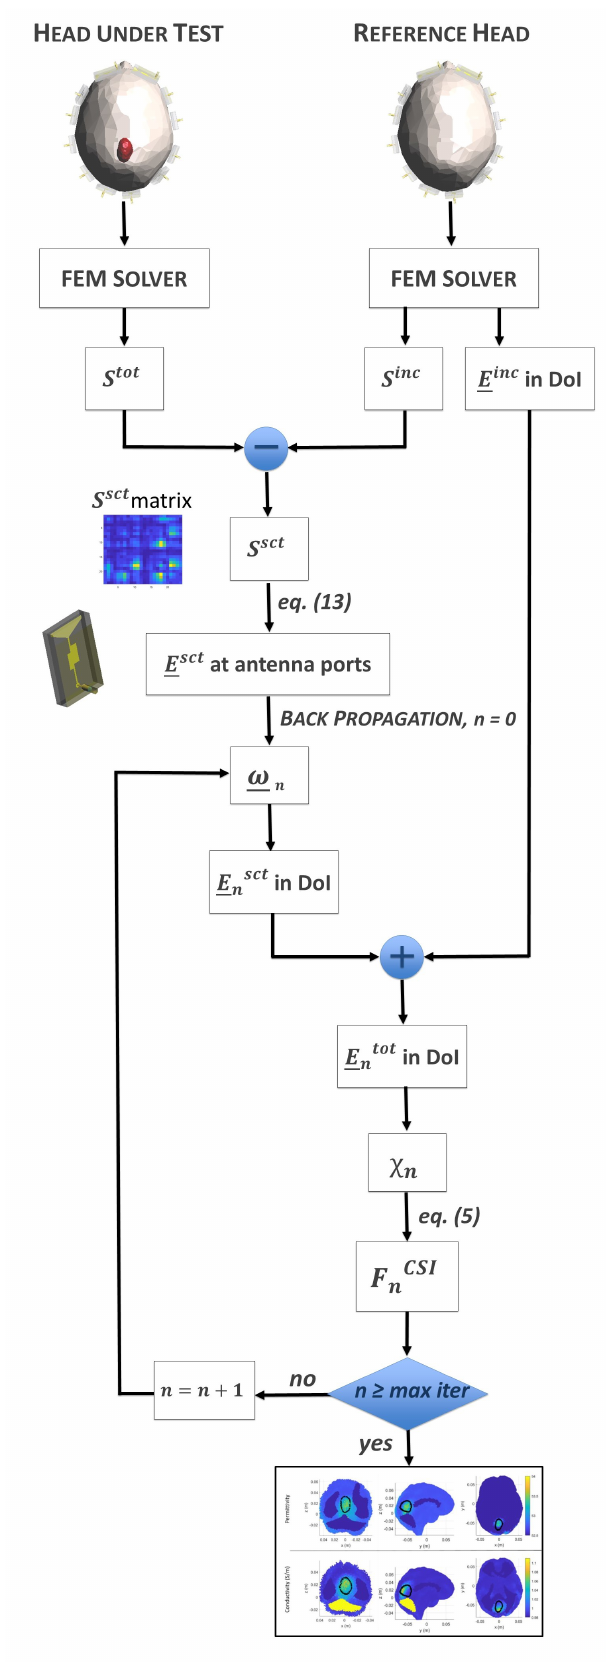
Figure 4. Flowchart of the implemented CSI